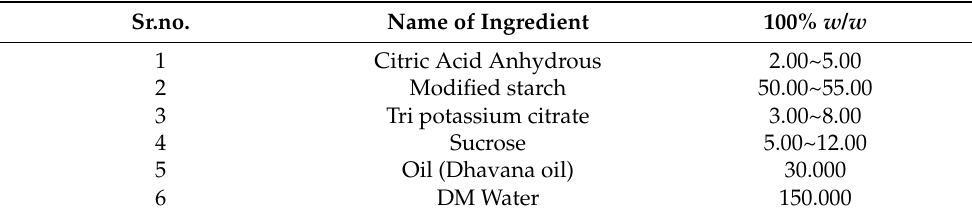
Table 1. Final formulation of preparation of Dhavana oil emulsion. Sr.no.